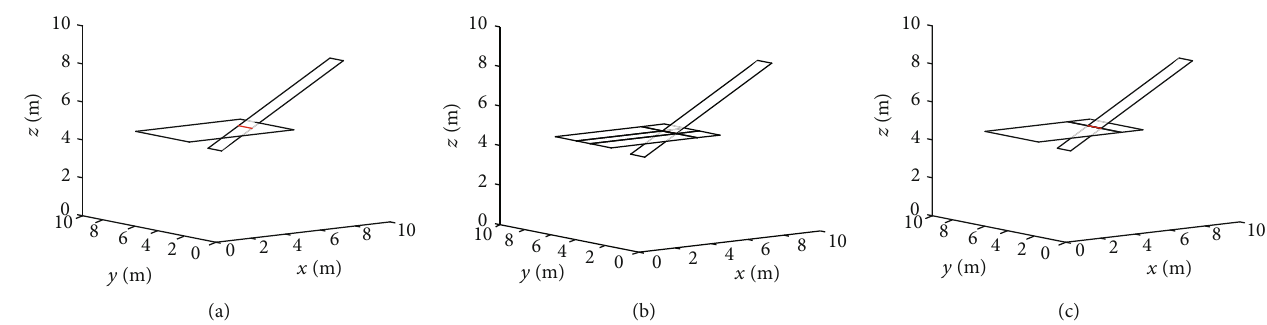
Figure 1: Example of (a) two intersecting fractures that have been divided into (b) 8 subfractures with the method Inter1 and (c) 4 subfractures with the method Inter2 . The intersection line between the two main initial fractures is shown in red.